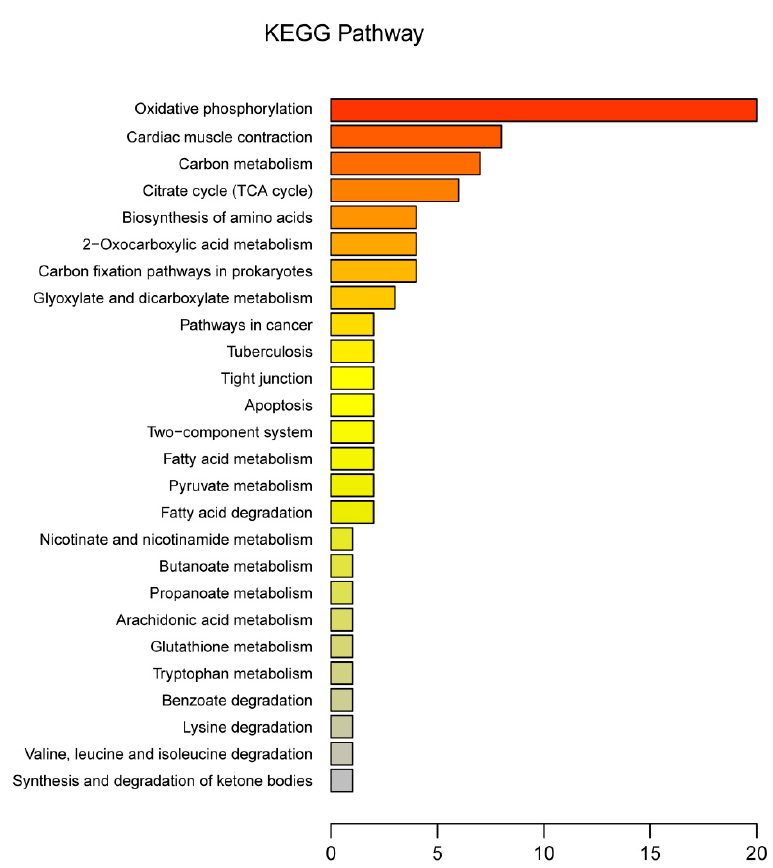
Figure 5. Kyoto Encyclopedia of Genes and Genomes (KEGG) pathway analysis of protein. The X-axis is the number of differentially expressed proteins enriched on this pathway.